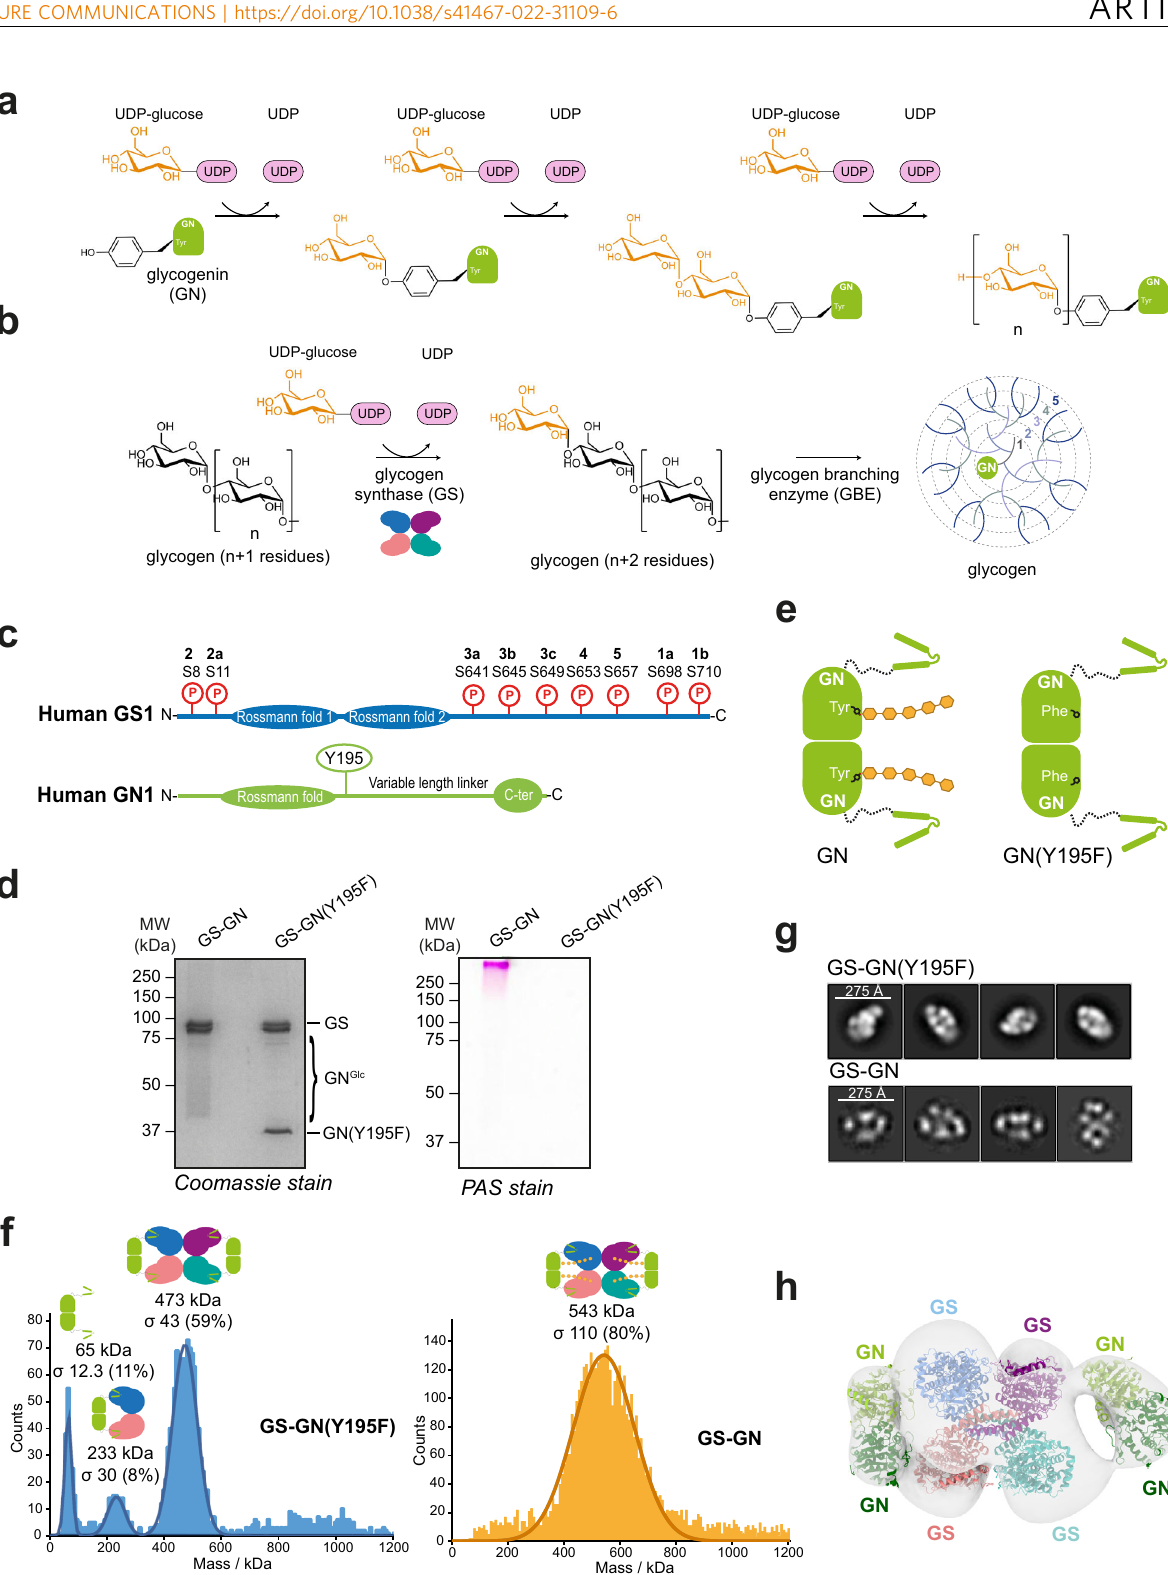
species (Fig. 1f). While mass photometry measurements lack the resolution to ascertain the precise molecular mass of hetero- geneously glucosylated species, the observed increase in average molecular mass and overall distribution of the WT complex when compared to the Y195F complex is consistent with the observed higher molecular weight of WT GN1 glucosylated species (Fig. 1d and Supplementary Fig.